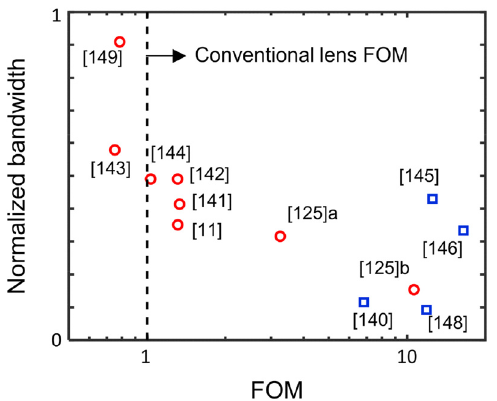
Figure 13: Comparison of experimentally demonstrated broadband metalenses. Figure of merit (FOM) and operating normalized bandwidth( Δ λ / λ c )ofeachmetalensaregraphicallyrepresented.FOM is represented in logarithmic scale. Red circles correspond to transmission type metalenses. Blue squares correspond to re fl ection type metalenses. Black dotted line shows FOM of conventional lens with dispersion-less refractive indices. For calculation of Δ n in FOMs, whichisde fi nedas Δ n=n 1 − n 2 ,representativeindicesfor eachband were chosen and then were assumed to be dispersion-less over the band. Utilized refractive indices for each data point are as